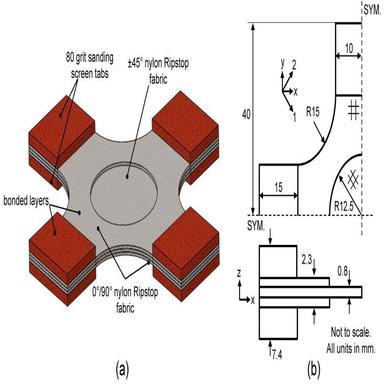
(a) Isometric view and (b) dimensions of the parachute fabric specimen. The x-y coordinates correspond to global loading direction while the 1–2 coordinates correspond to local material orientation in the gage region.